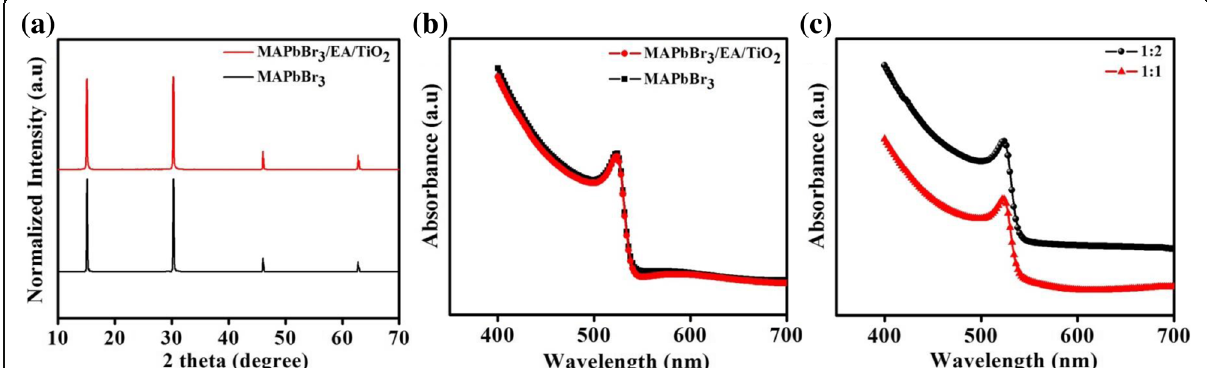
Fig. 2 a X-ray diffraction patterns of the MAPbBr 3 film and the MAPbBr 3 /EA/TiO 2 trilayer film. b MAPbBr 3 film and MAPbBr 3 /EA/TiO 2 trilayer film absorption spectra. c Absorption spectra at different ratios of PbBr 2